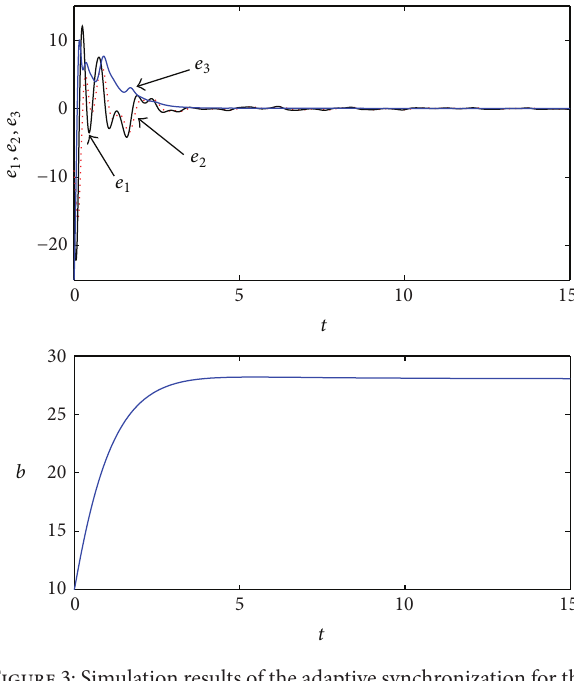
Figure 3: Simulation results of the adaptive synchronization for the fractional-order Lorenz chaotic